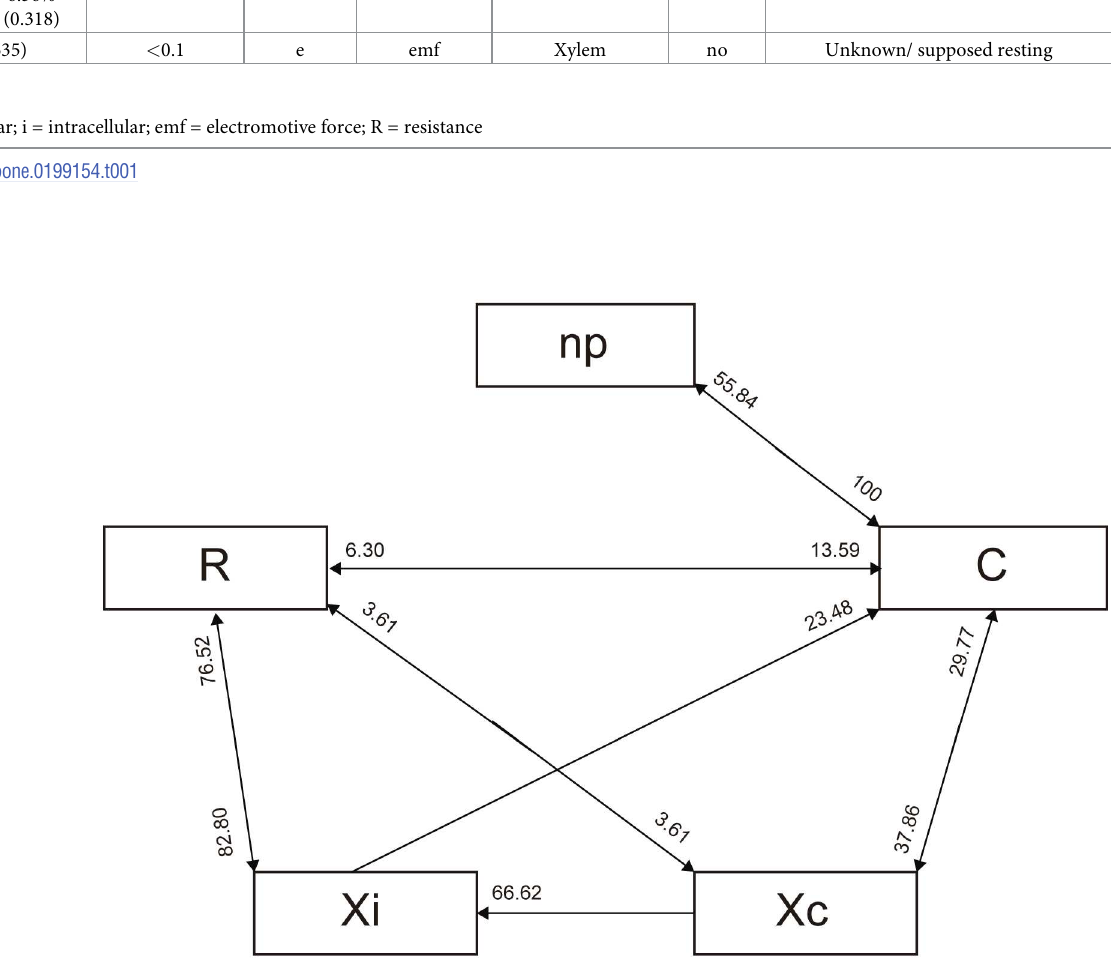
Fig 4. Transition scheme of waveforms events for P . spumarius on olive cv Picual during the 8 hours EPG (likelihood of waveforms events). The values near the arrows correspond to the likelihood of a certain waveform being followed by another waveform type. Probabilities < 2% are not shown. Waveform N was not represented in the diagram, because it occurs as brief interruption within waveforms Xc and Xi (and likely